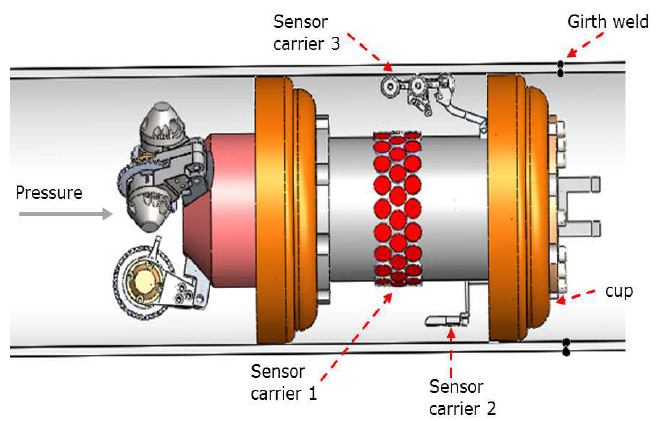
Figure 1. Pipeline inspection gauge capsule with different types of sensor carriers